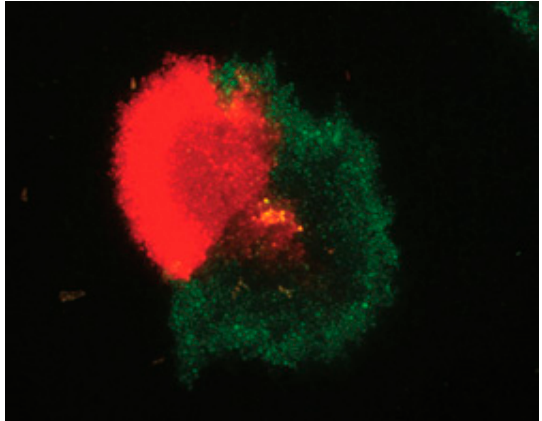
Figure 4. Fluorescence profile of a C. quinoa local lesion observed 7 days post infection after rub ‐ inoculation of BNYVV RNA1 and RNA2 supplemented with a mixture of two replicons derived from BSBMV and BNYVV RNA3s, expressing monomeric red fluorescent protein (mRFP) and enhanced green fluorescent protein (EGFP), respectively. This image illustrates the existence of an exclusion mechanism for similar but distinct RNA species during the progression of the infection, with both replicons being able to be encapsidated by BNYVV CP (details are described in Ratti et al, 2009